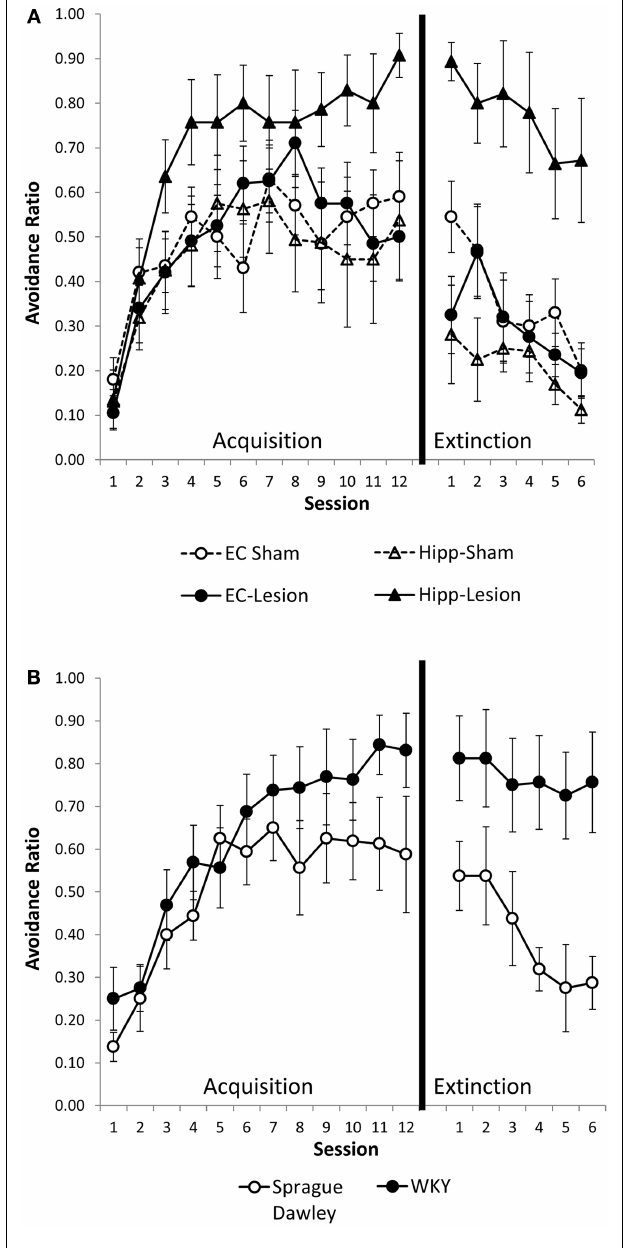
FIGURE 2 |Avoidance acquisition and extinction following hippocampal and entorhinal cortex lesion and inWKY rats . Hippocampal and entorhinal cortex lesions did not alter avoidance acquisition (A) . Rats with hippocampal lesions were impaired in extinction learning compared to sham controls (A) . Acquisition of avoidance inWKY rats did not differ from SD rats (B) .WKY rats exhibited a trend toward impaired extinction of avoidant responding (B) . Although all six groups were statistically analyzed together, lesion (A) and unoperated (B) groups are displayed separately for